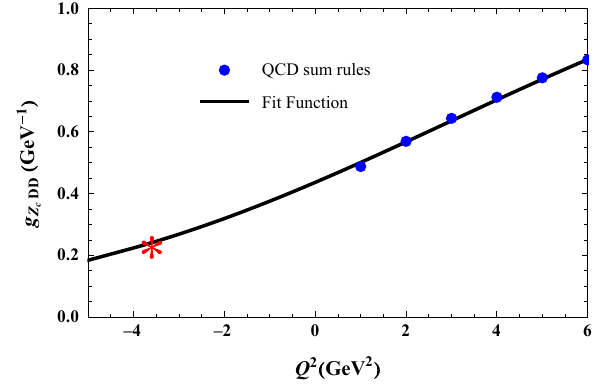
Fig. 4 Thesumrulepredictionsandfitfunctionforthestrongcoupling ( Q 2 ) . The star marks the point Q 2 = − m 2 g Z c DD